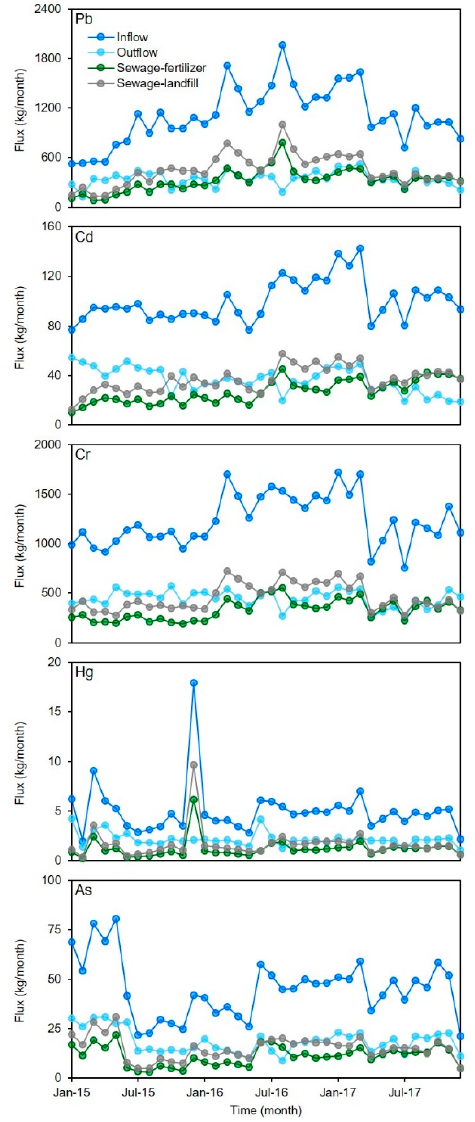
Figure 3. Temporal variations of five heavy metals flux at sampled MWTPs.